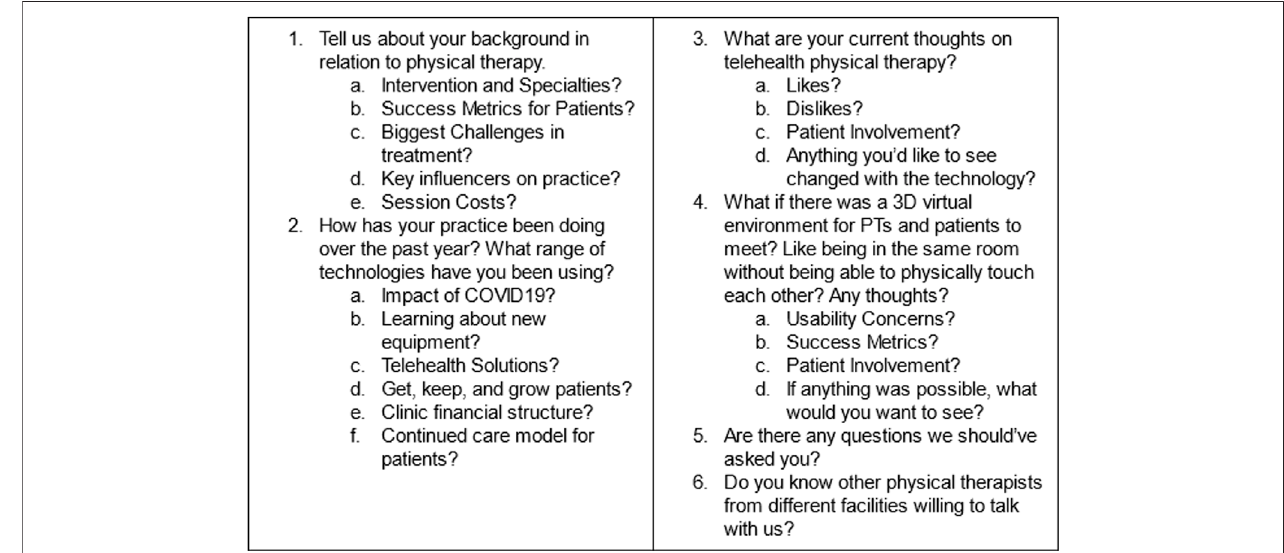
FIGURE 1 | Box interview guide utilized in sessions with physical